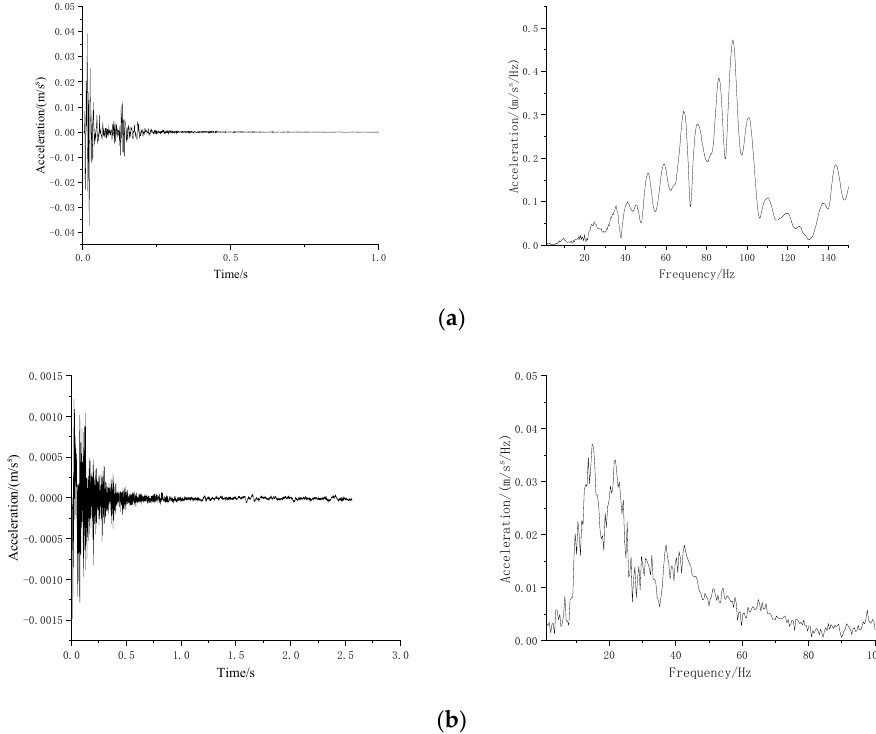
Figure 8. Typical time histories and Fourier spectra of vibration responses for the conditions ( a ) without and ( b ) with the mat.